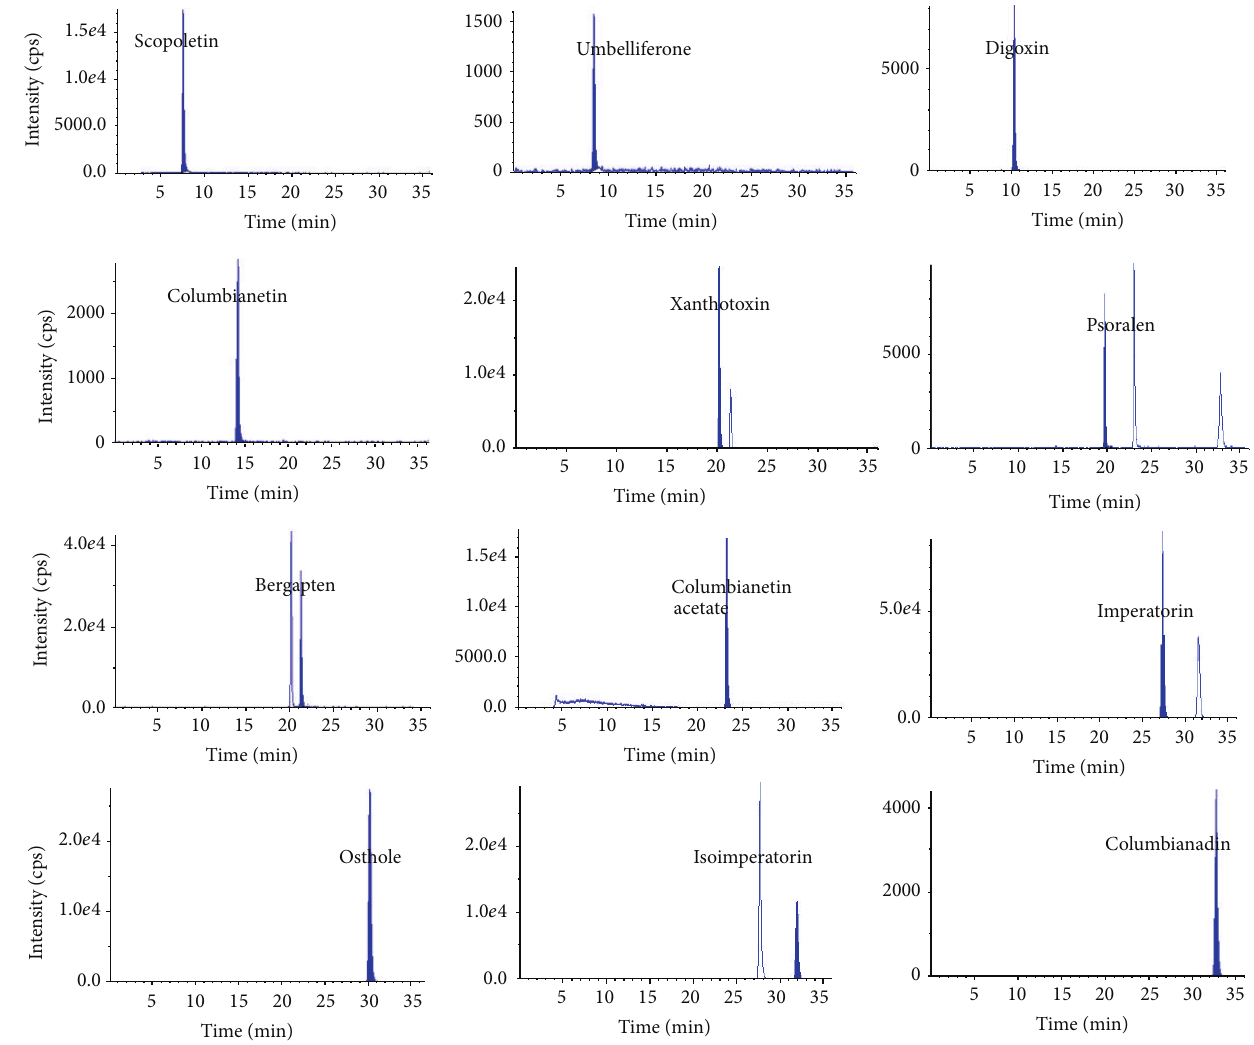
Figure 2: Typical MRM chromatograms of eleven authentic standards